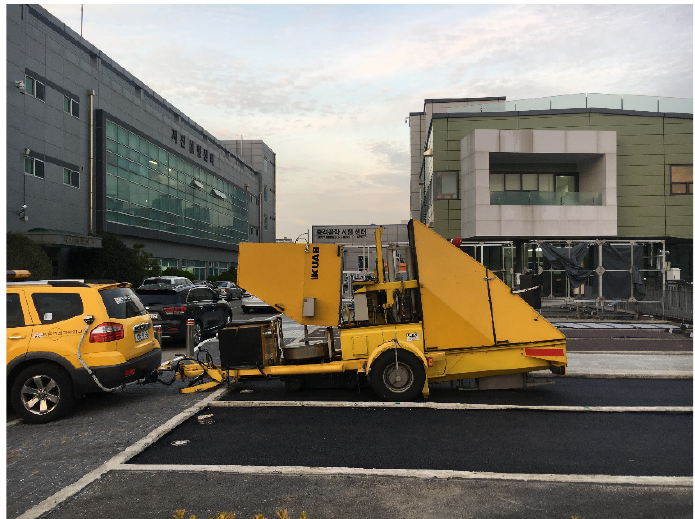
Figure 8. FWD test for pavements.